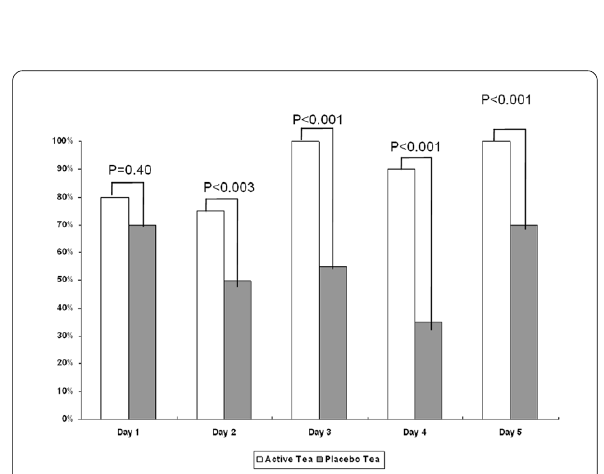
Figure 2 Proportion of one or more evacuations/day according to treatment period (active tea vs. placebo)